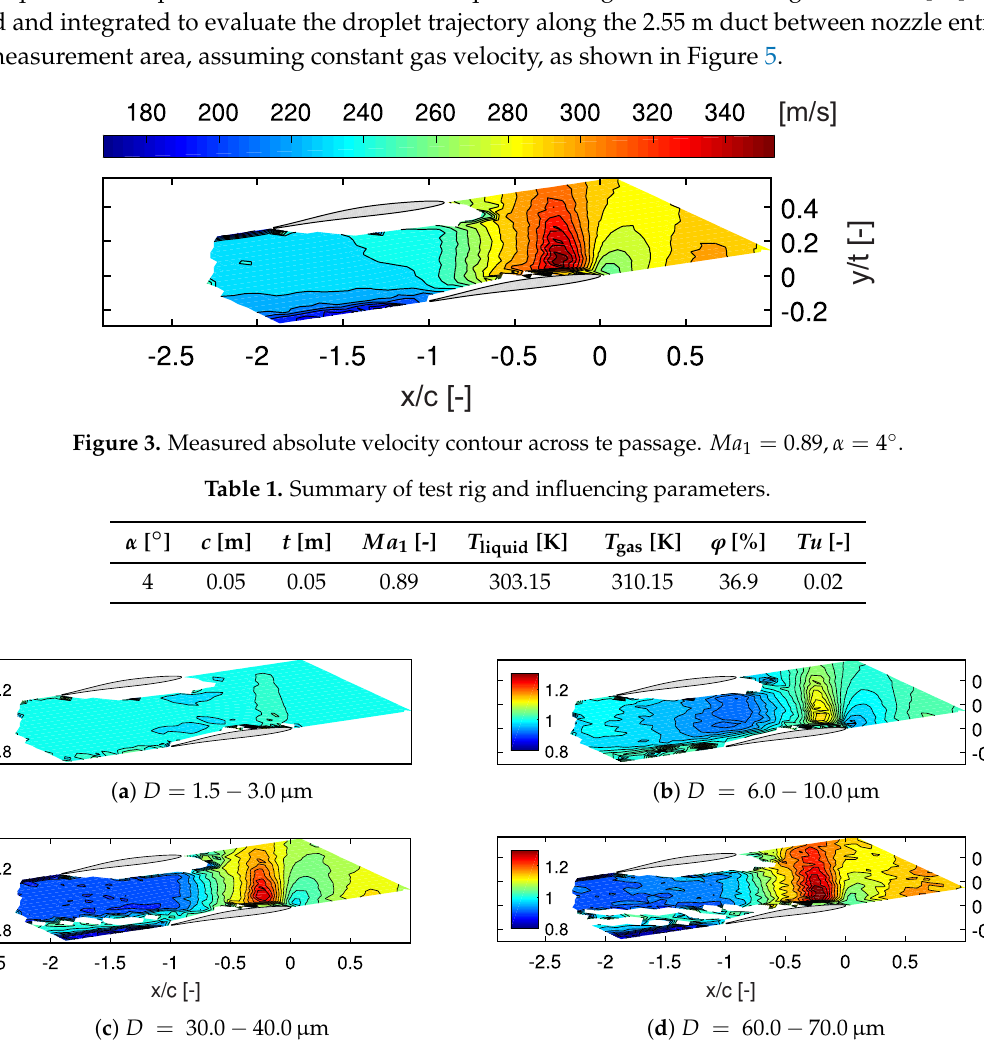
Figure 4. Contours of slip ratio S throughout the cascade passage for small, intermediate, and large droplet diameters. Flow is from right to